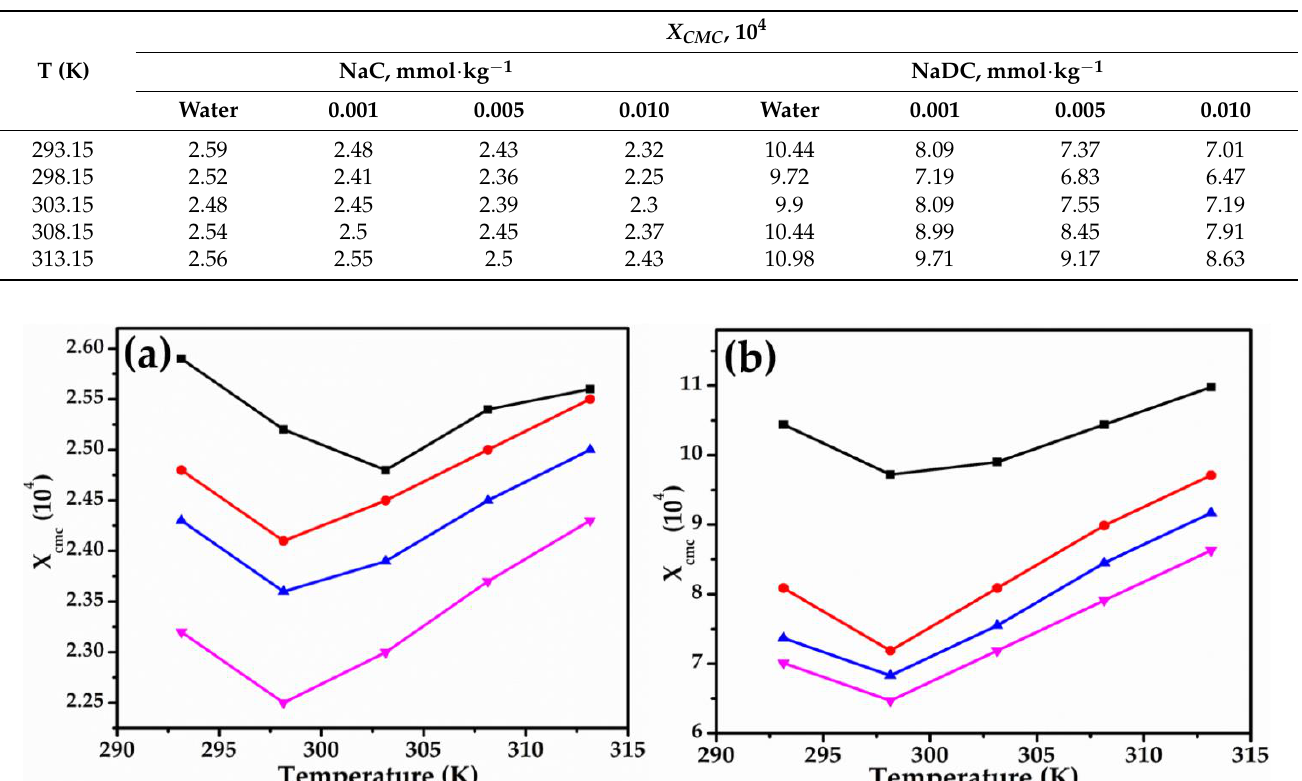
Table 3. X CMC values of bile salts in studied concentration of aqueous glycyl dipeptide at various temperatures and experimental pressures, p = 0.1 MPa.